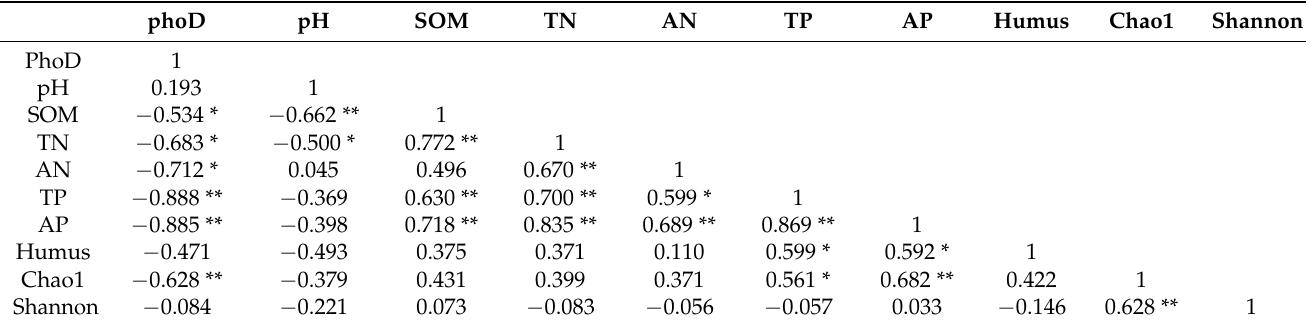
Table 3. Pearson correlations between phoD gene abundance, soil properties, and α diversity under different